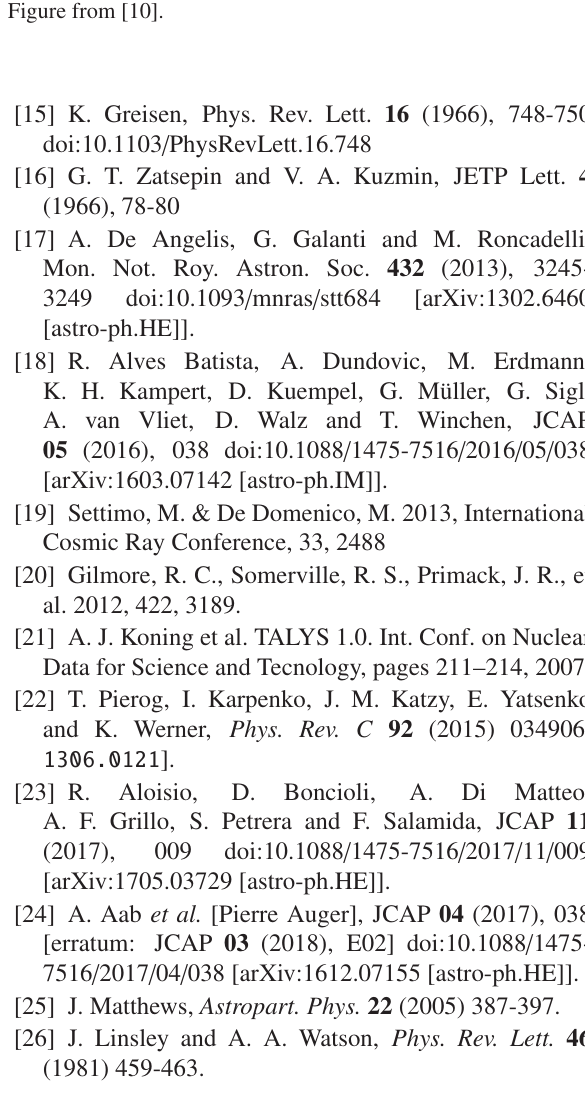
Figure 6. Maximum with respect to α of the mixed relative fluctuations obtained using the parameterizations in the standard case (dashed curve) and in the presence of LIV considering η in the range [ − 10 − 3 , − 10 − 15 ] (coloured curves) as a function of the primary energy. Each color corresponds to a di ff erent violation strength (right axis). The black points with error bars (statistical uncertainties) represent the measured relative fluctuations in the number of muons. Figure from